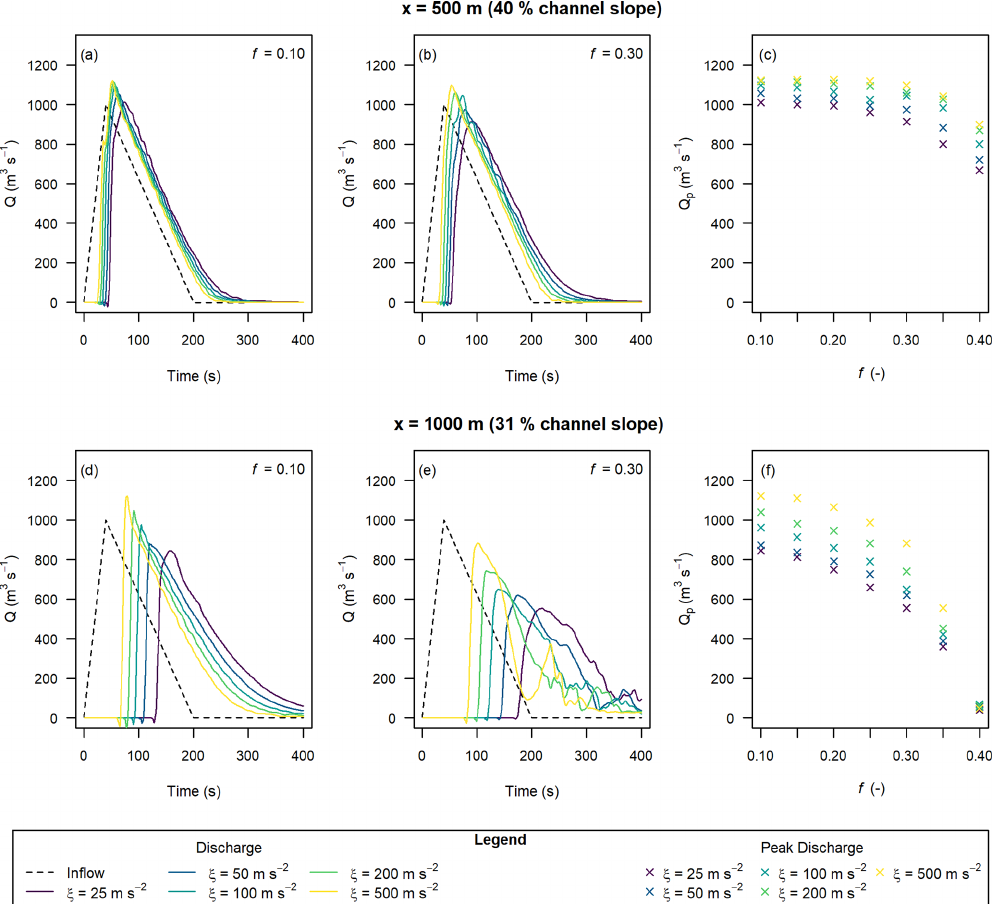
Figure 5. Hydrographs extracted at x = 500m (a–c) and x = 1000m (d–f) with varying Voellmy parameters and Q p = 1000m 3 s − 1 , based on triangular input